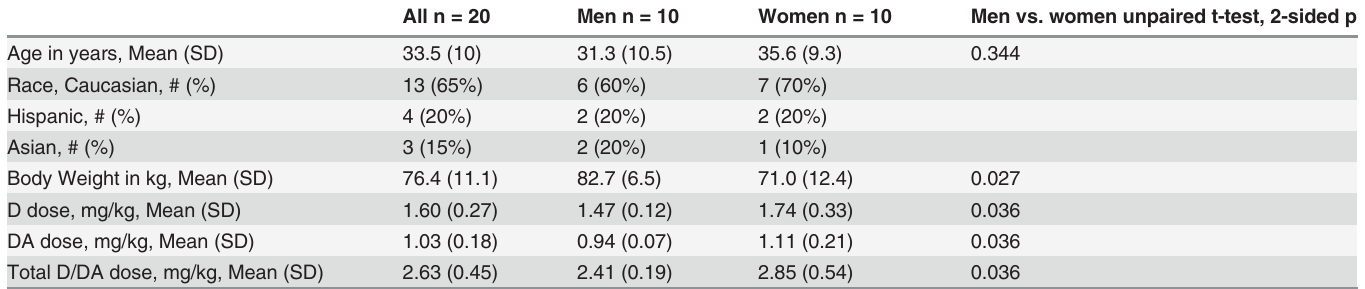
Table 1. Baseline characteristics of healthy subjects and dosage information for decursin (D) and decursinol angelate (DA) normalized to body